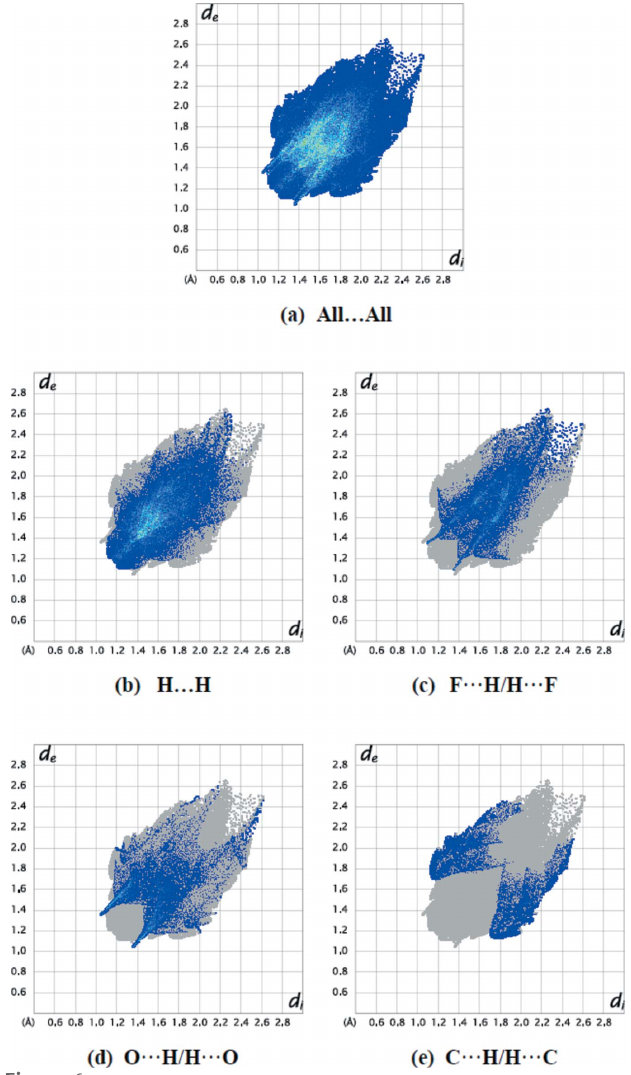
Figure 6 Two-dimensional fingerprint plots for title molecules showing ( a ) all interactions, and delineated into ( b ) H (cid:3)(cid:3)(cid:3) H, ( c ) F (cid:3)(cid:3)(cid:3) H/H (cid:3)(cid:3)(cid:3) F, ( d ) O (cid:3)(cid:3)(cid:3) H/ H (cid:3)(cid:3)(cid:3) O and ( e ) C (cid:3)(cid:3)(cid:3) H/H (cid:3)(cid:3)(cid:3) C interactions. The d i and d e values are the closest internal and external distances (in A˚ ) from given points on the (cid:4) z Hirshfeld surface. , y (cid:4) 1 , z ; (iv) 1 + x , y , 3 2 2 2 2